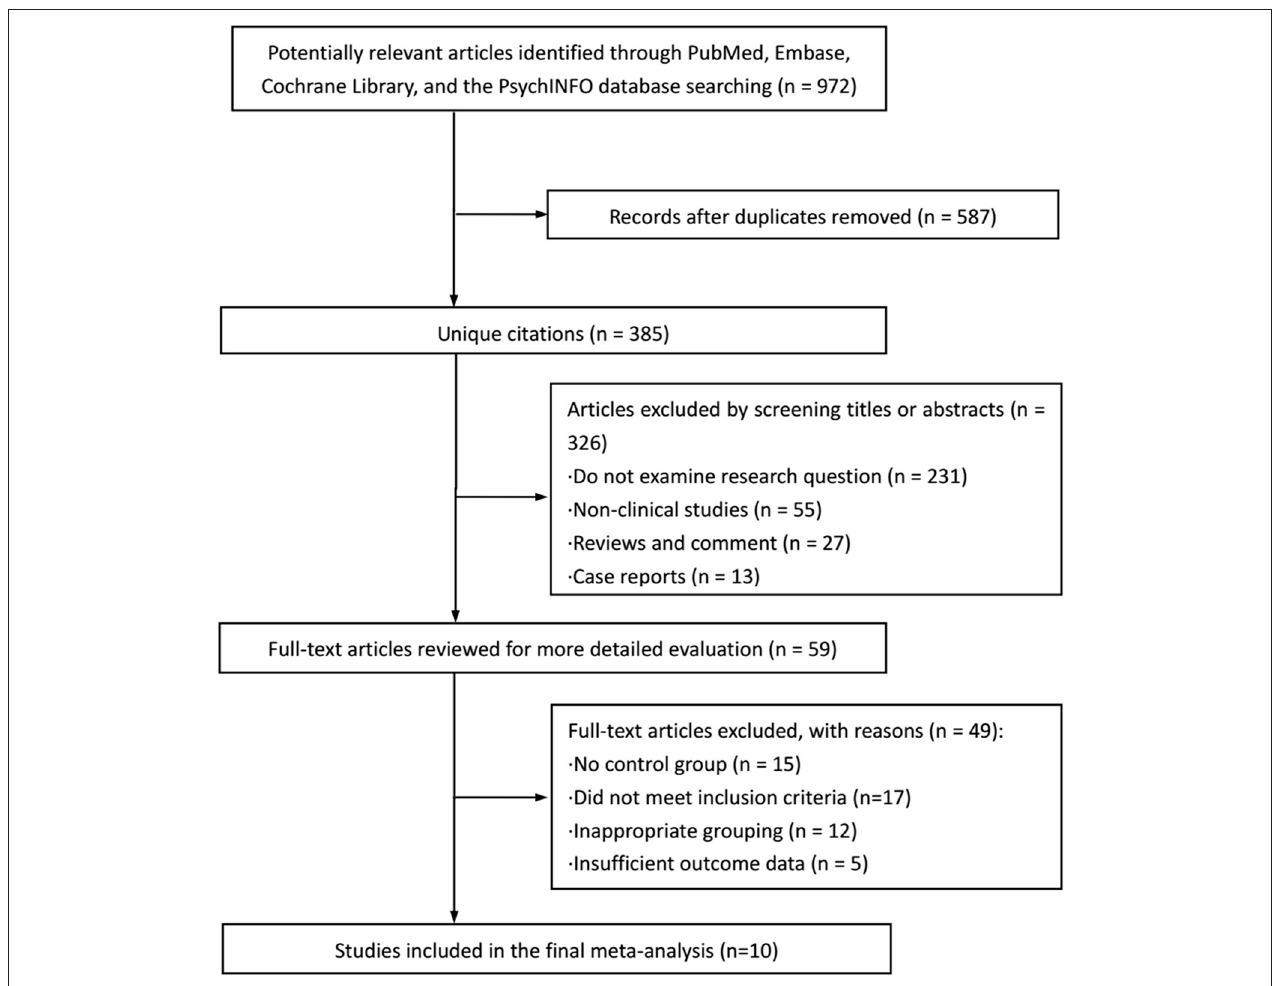
FIGURE 1 | Flow chart of study